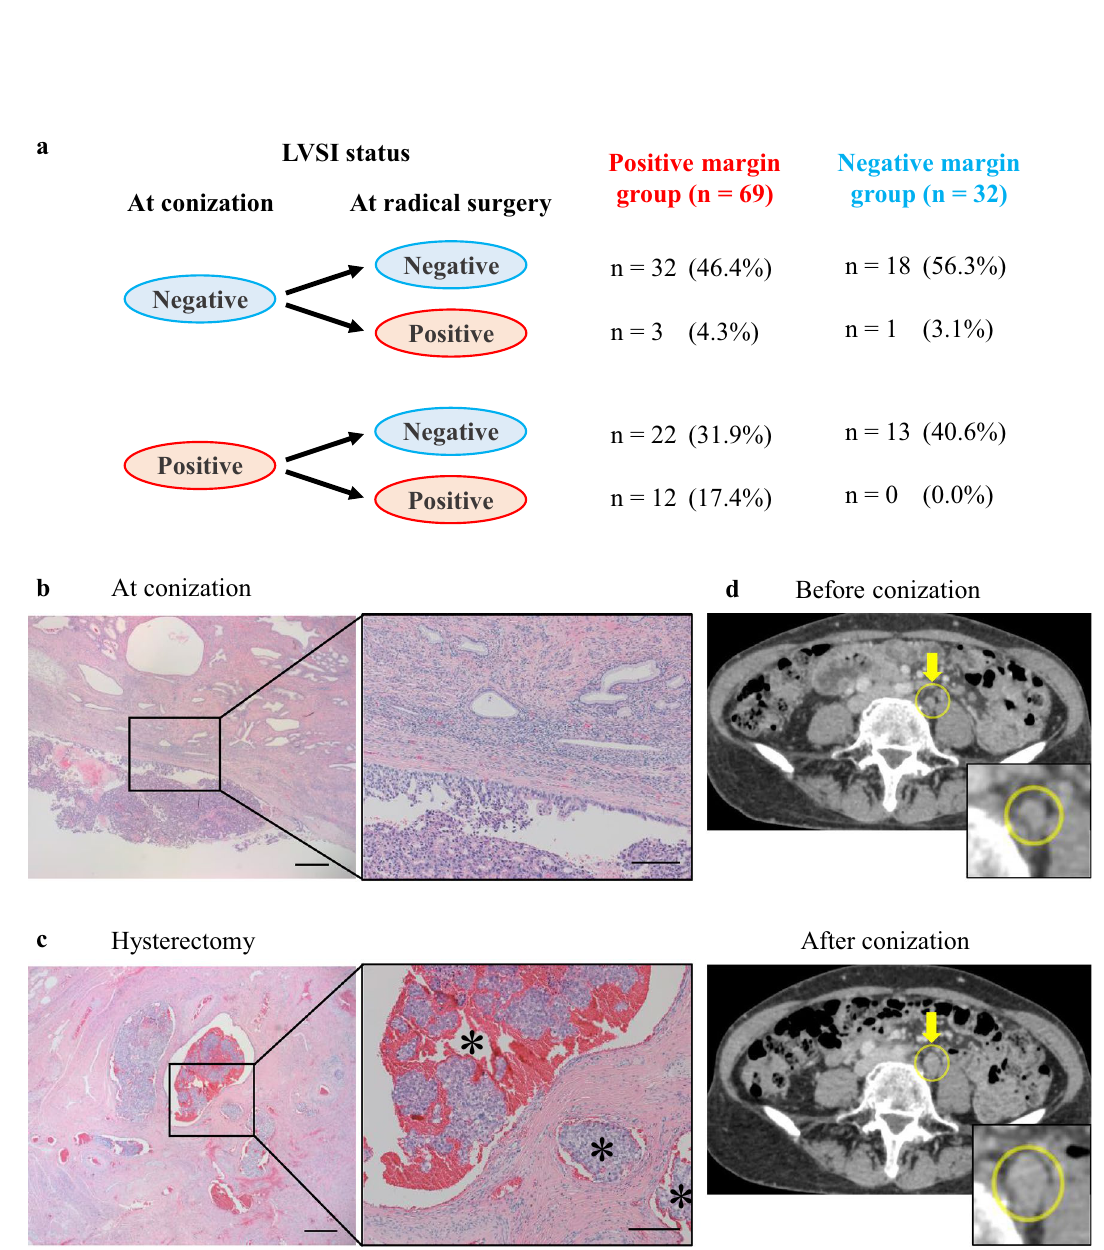
Figure 2. LVSI status at conization and at radical surgery. (a) The relationship between LVSI at conization and at radical surgery. (b,c) Representative histological images. Asterisks indicate tumors in vessels (LVSI positive). The scale bars: left; 50 µm and right; 20 µm. (d) Representative computed tomography images of the case before/ after